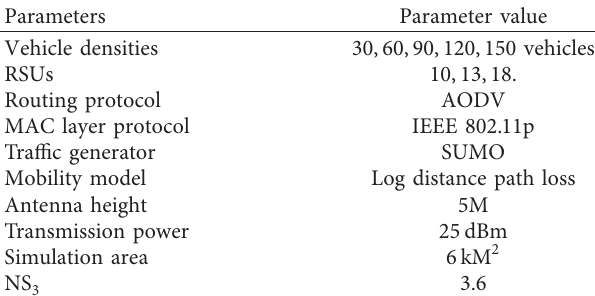
Figure 20: Square grid cell centroid. Table 2: Simulation parameters (parameters used and their